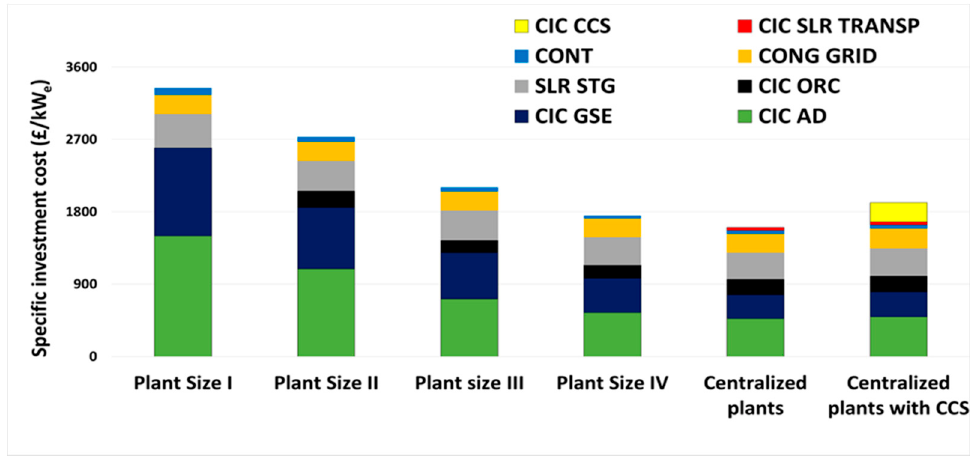
Figure 3. Specific investment cost for the different plant sizes.